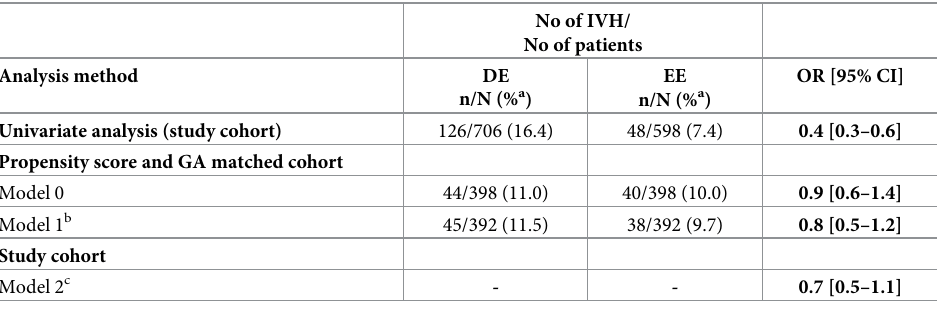
Table 3. Severe IVH and early